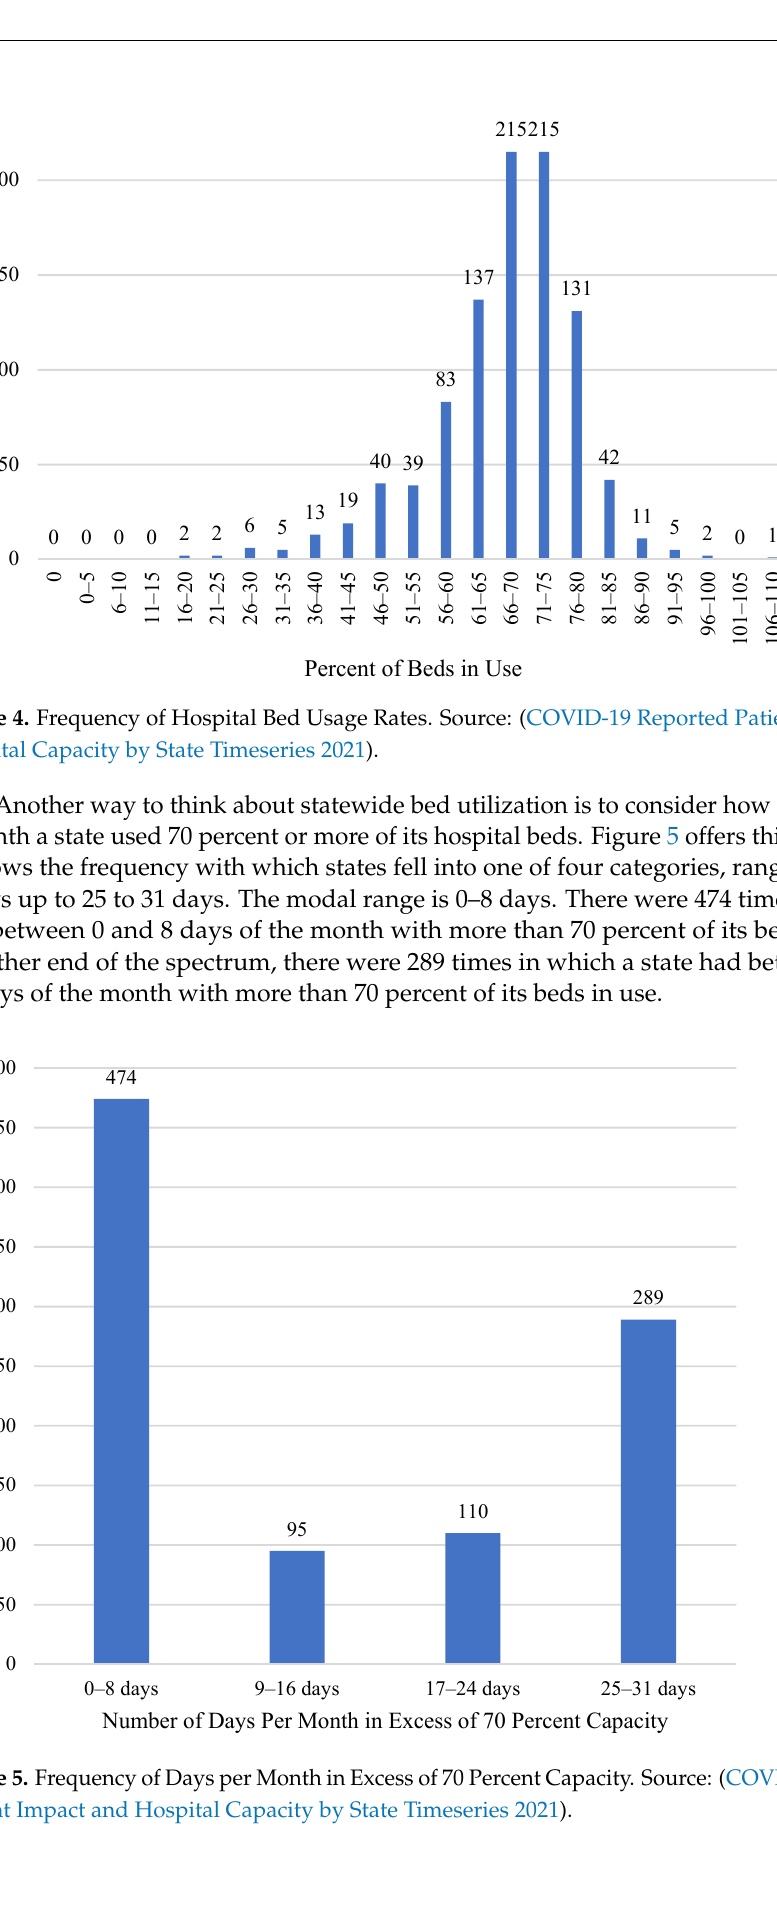
5 of 19 Table 1. Descriptive Statistics, Observations by State and Month. Obs